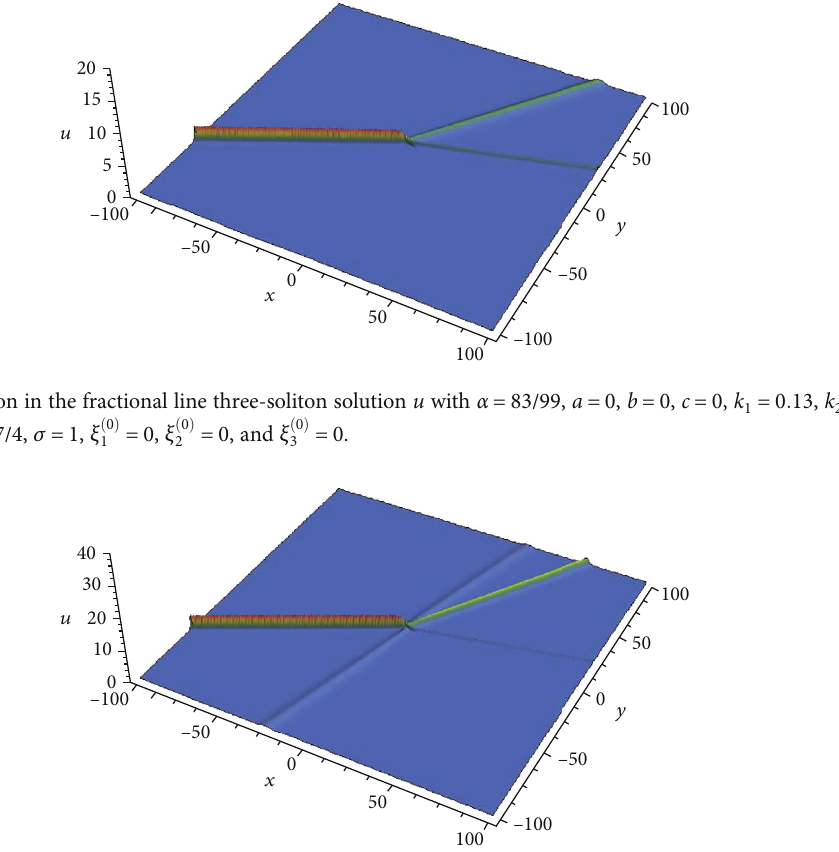
= 0 : 13 , k = 1 : 13 , k = 2 : 13 , 1 2 3